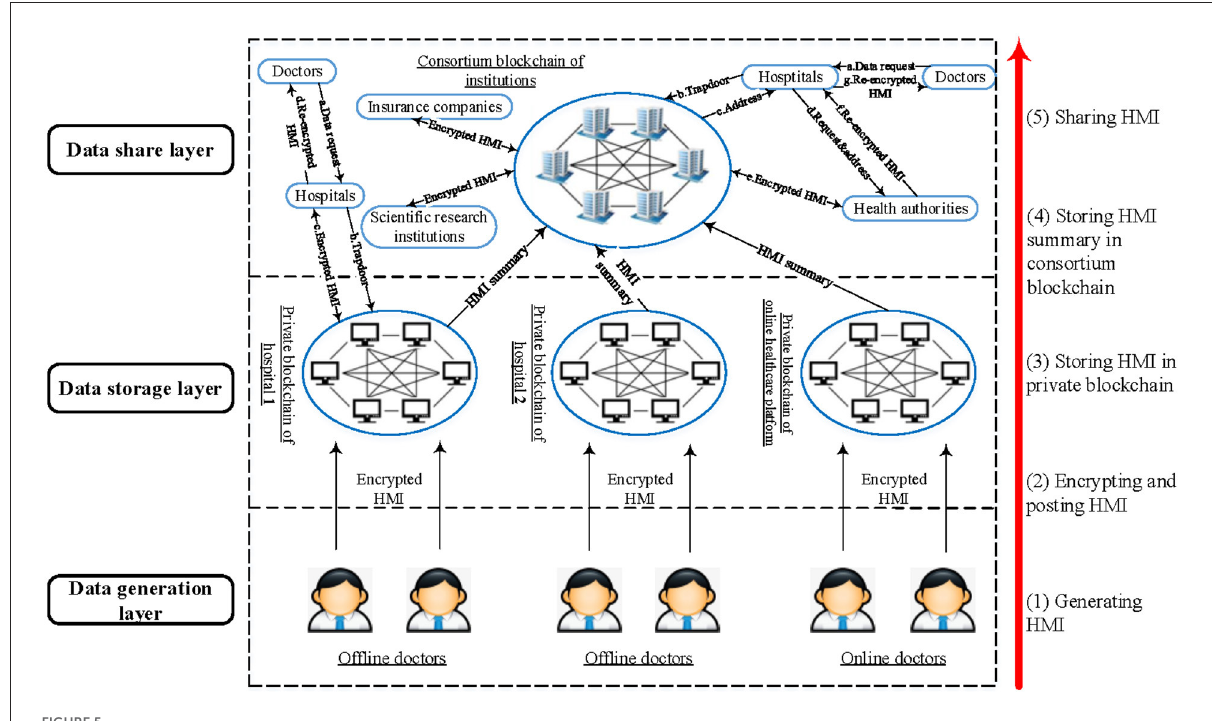
FIGURE5 The protocol in the MBDS